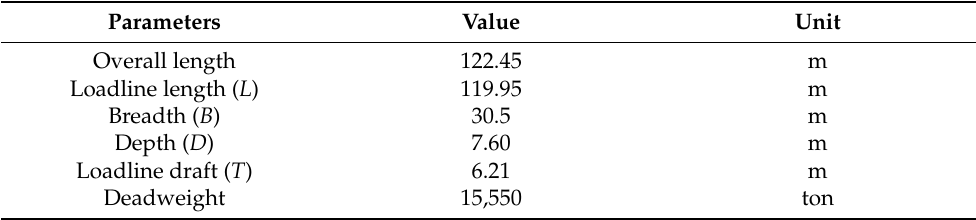
Table 1. Main dimensions of the